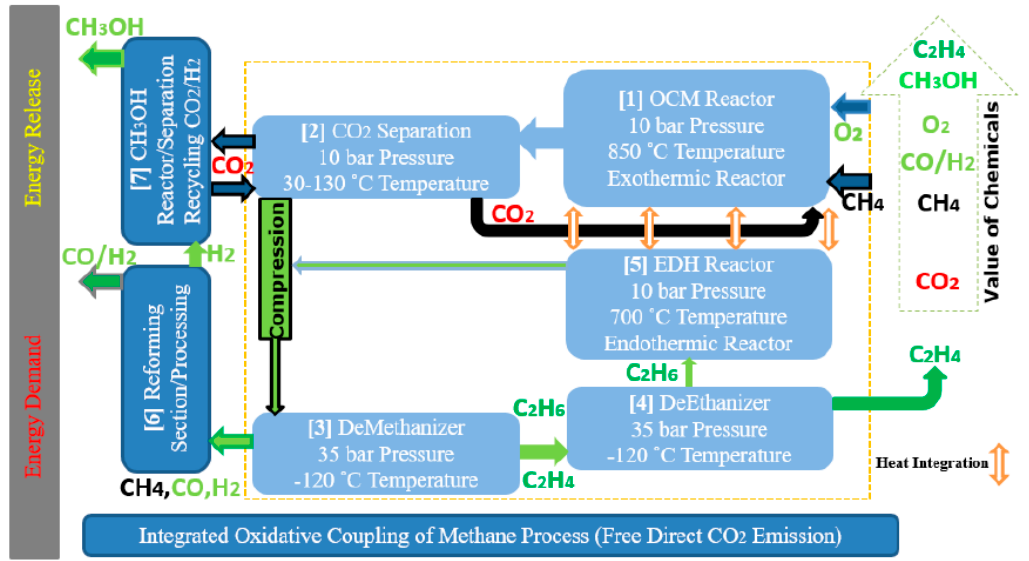
Figure 1. The process block-flow diagram of alternative Oxidative Coupling of Methane (OCM) process structures investigated in this research.